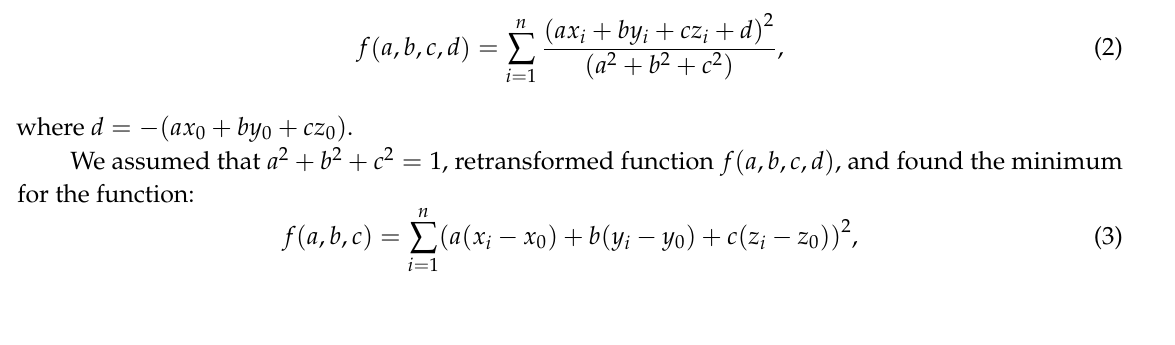
Figure 11. Three-dimensional (3D) presentation of the part of the crane rails with profiles.